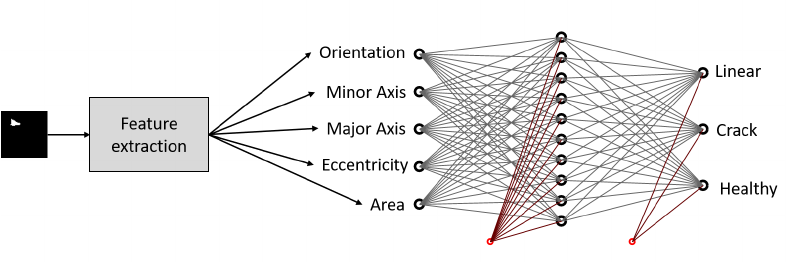
Figure 6. Architecture of the second spot analysis method tested: the image is preprocessed and some features are extracted. These features are used as input for the neural